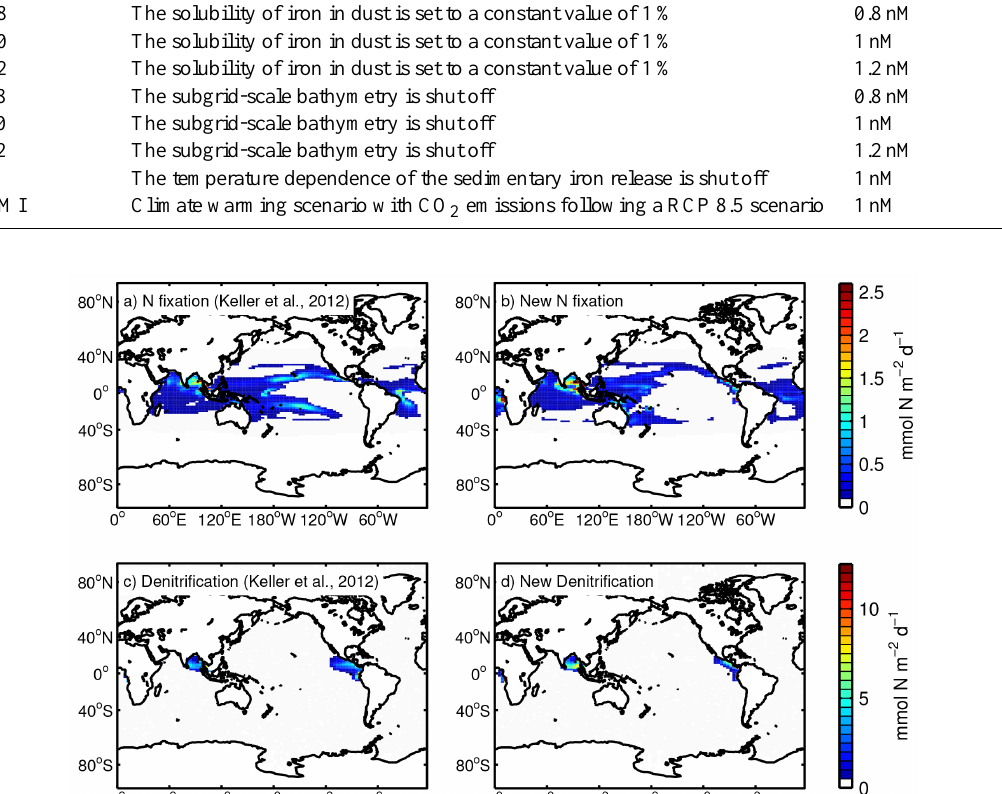
Figure 16. Annual mean nitrogen fixation with the model by Keller et al. (2012) (a) and the new model (b) and denitrification with the model by Keller et al. (2012) (c) and the new model (d) . Values below 0.1mmolNm − 2 d − 1 are not shown for (a) and (b) while values below 0.5mmolNm − 2 d − 1 are not shown for (c) and (d)